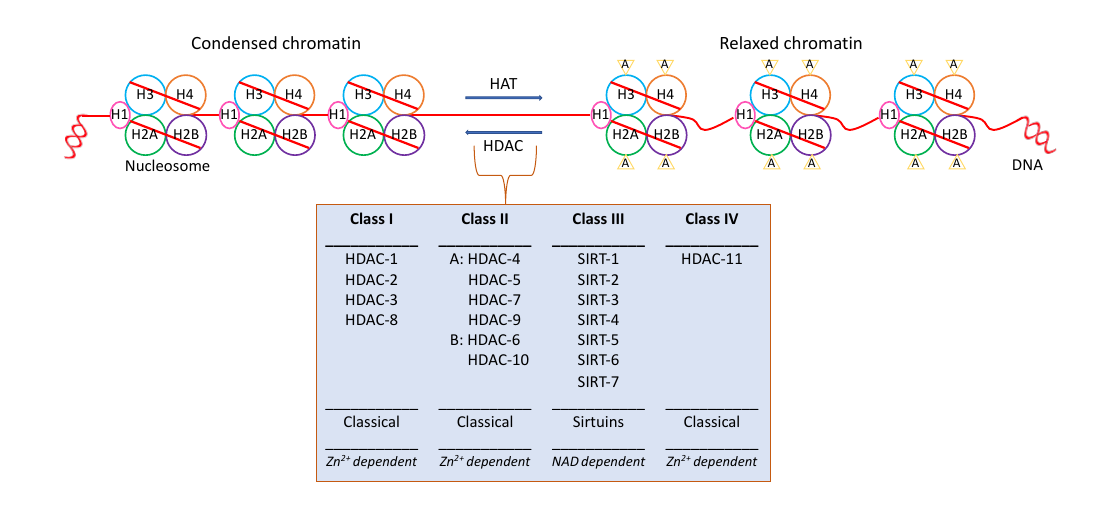
Figure 1. Histone deacetylases’ function and classification.